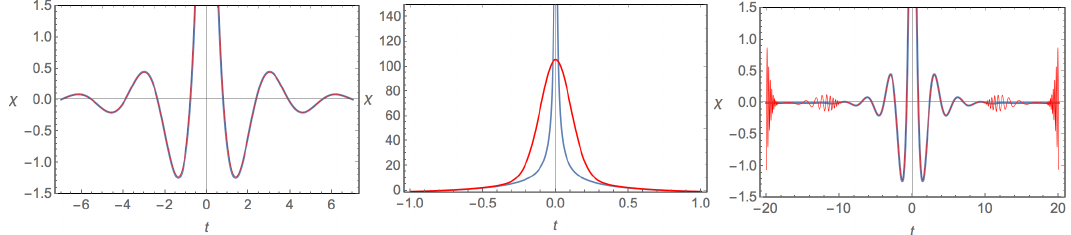
Figure 12 . Comparison of d = 1 character χ ( t ) defined in (B.1) (blue) to the coarse-grained discretized character ¯ χ ( t ) defined in (B.11) (red), with δ = 0 . 1 and other parameters as in N,δ figure 11. Plot on the right shows wider range of t . Plot in the middle smaller range of t , but larger χ .